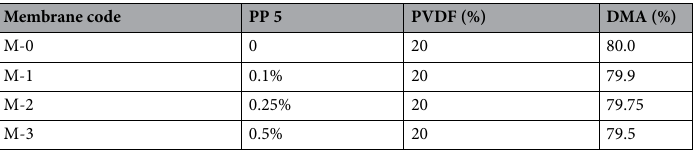
Table 1. Composition of Zwitterionic PP 5 and applied parameters for the synthesis of the various PVDF membranes a . a Polymer dope solution temperature and coagulation bath temperature were kept at 25